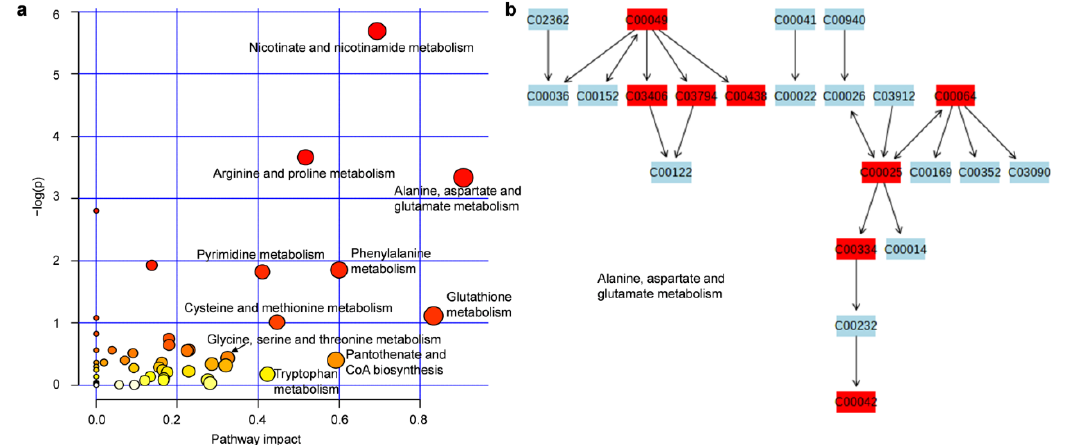
Figure 3. MetPA visualization diagram; ( a ) The metabolic pathways involved in the identified metabolites. Each dot means a metabolic pathway; ( b ) Alanine, aspartate and glutamate metabolism. Compounds ID were indicated in KEGG. The identified compounds were highlighted in red.